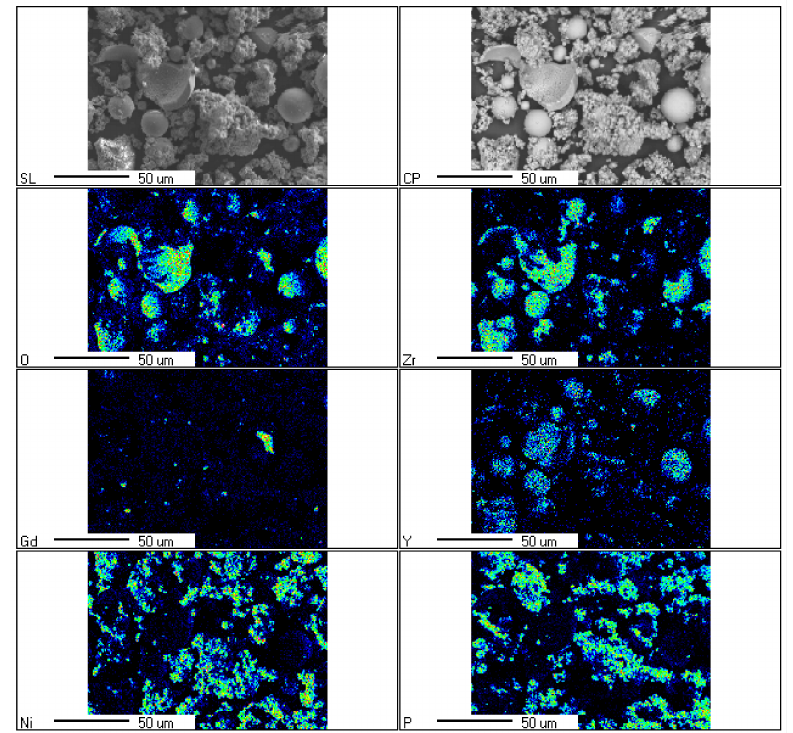
Figure 5. Element distribution maps, magnification 750 × (area 160 µ m × 120 µ